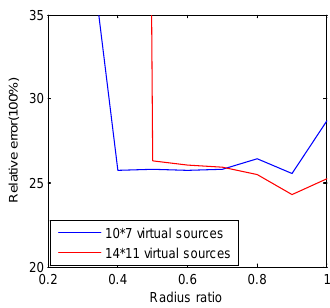
Figure 8. Different virtual source surface. ( a ) 14 × 11 Virtual sources; ( b ) 10 × 7 Virtual sources.